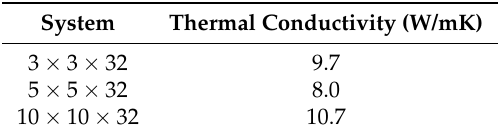
Table A2. Thermal conductivity of Pt-systems in vacuum in z-direction, and different sizes in x- and y-direction.